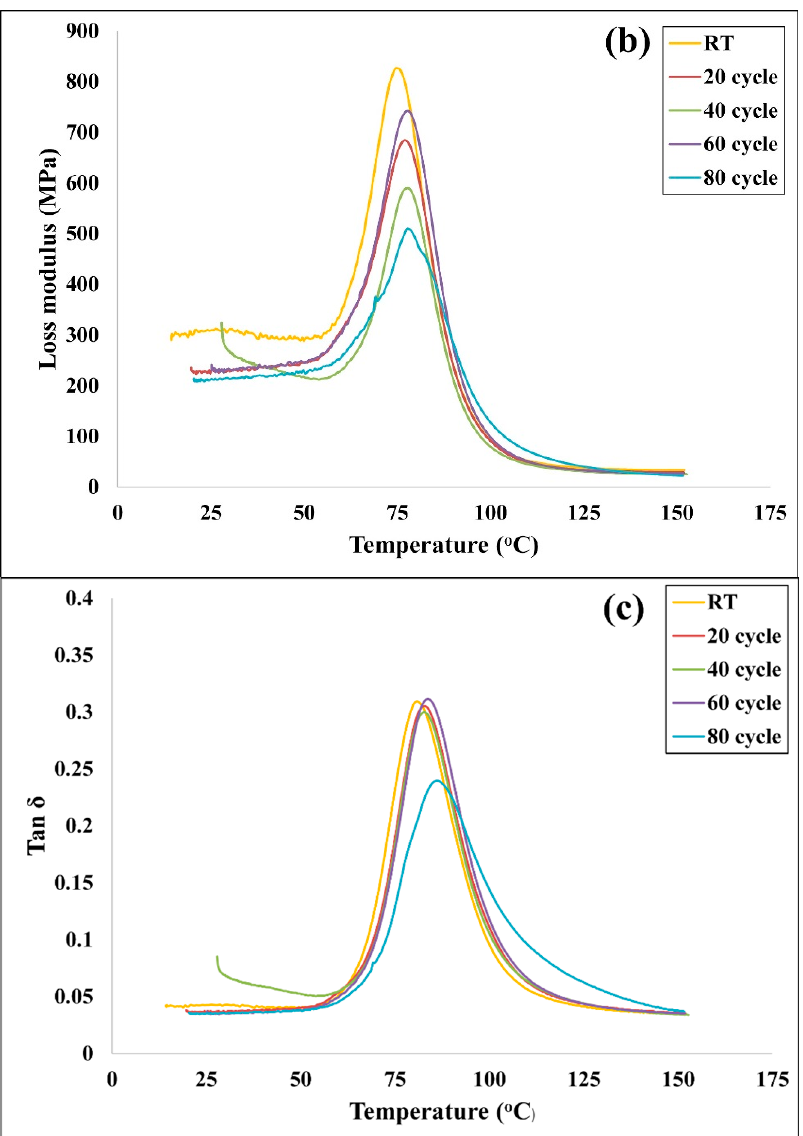
Figure 11. DMA results of RT and thermal-cycling-exposure CFRP samples: ( a ) storage modulus, ( b ) loss modulus and ( c ) loss factor.